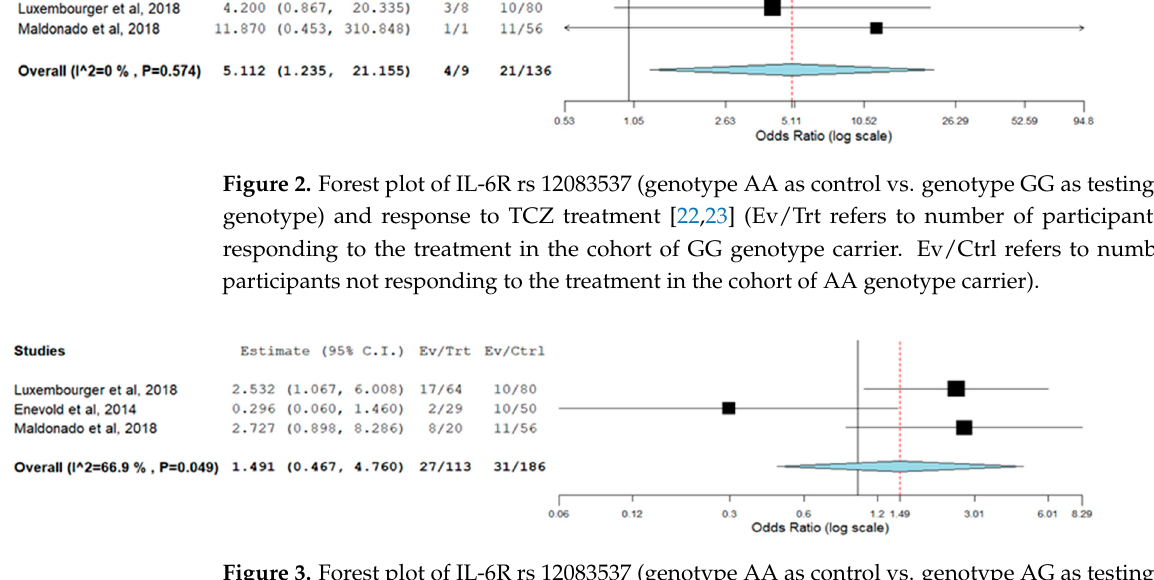
Figure 3. Forest plot of IL-6R rs 12083537 (genotype AA as control vs. genotype AG as testing/risk genotype) and response to TCZ treatment [20,22,23] (Ev/Trt refers to number of participants not responding to the treatment in the cohort of AG genotype carrier. Ev/Ctrl refers to number of participants not responding to the treatment in the cohort of AA genotype carrier).